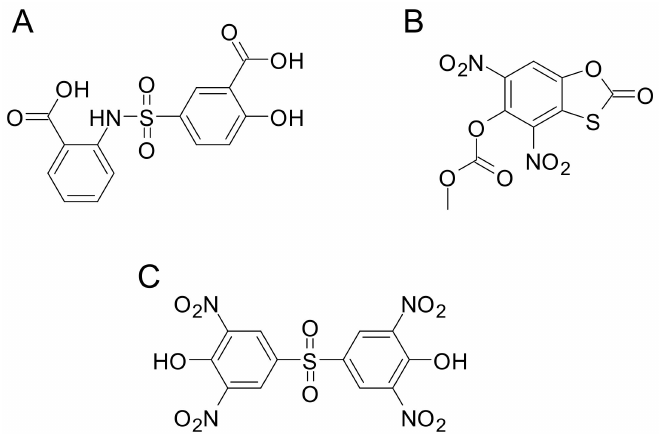
Figure 7. Chemical structures of compounds active against P. aeruginosa isochorismate pyruvate lyase PchB. Compound ( A ) was also active against E. coli chorismate mutase EcCM, compound ( B ) against the Yersinia enterocolitica salicylate synthase Irp9, and compound ( C ) against all these